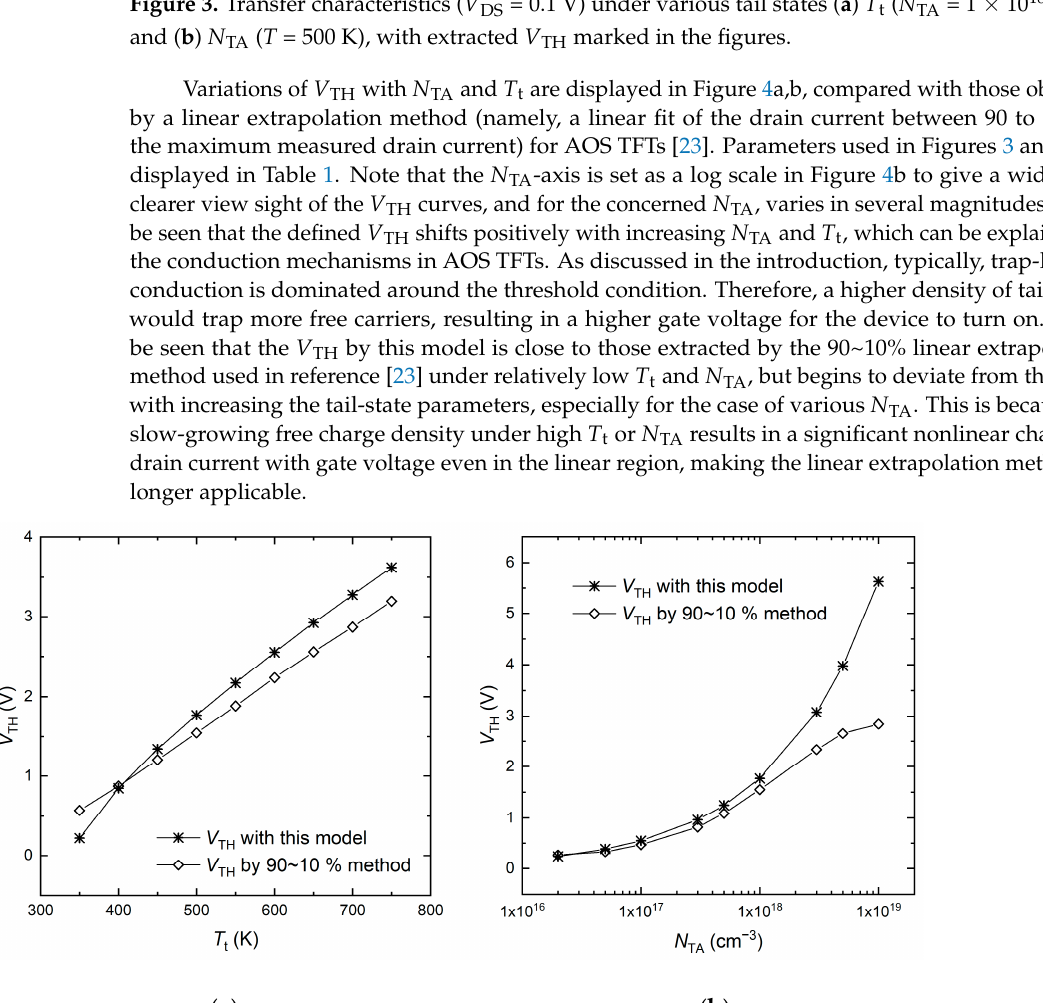
Figure 4. Variations of threshold voltage in Figure 3 with ( a ) T t ( N TA = 1×10 18 cm − 3 ) and ( b ) N TA ( T = 500 K).